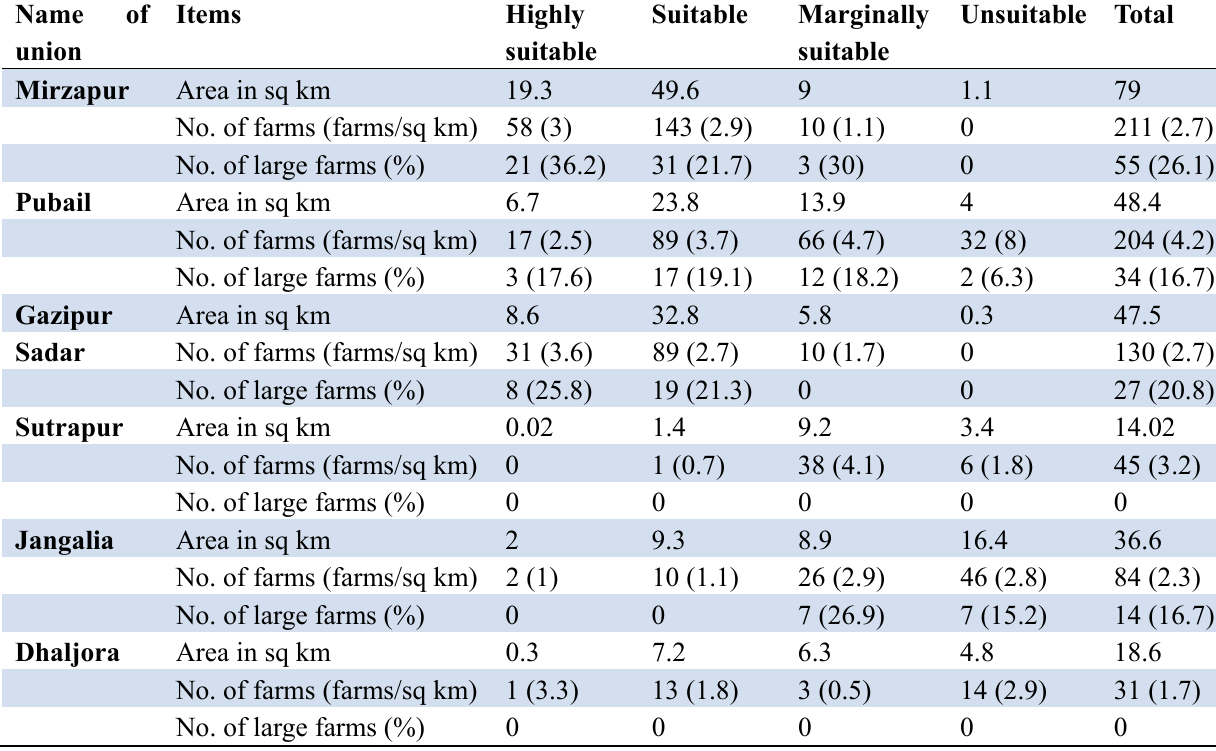
Table 3. Number of poultry farms in some unions according to predominant suitability